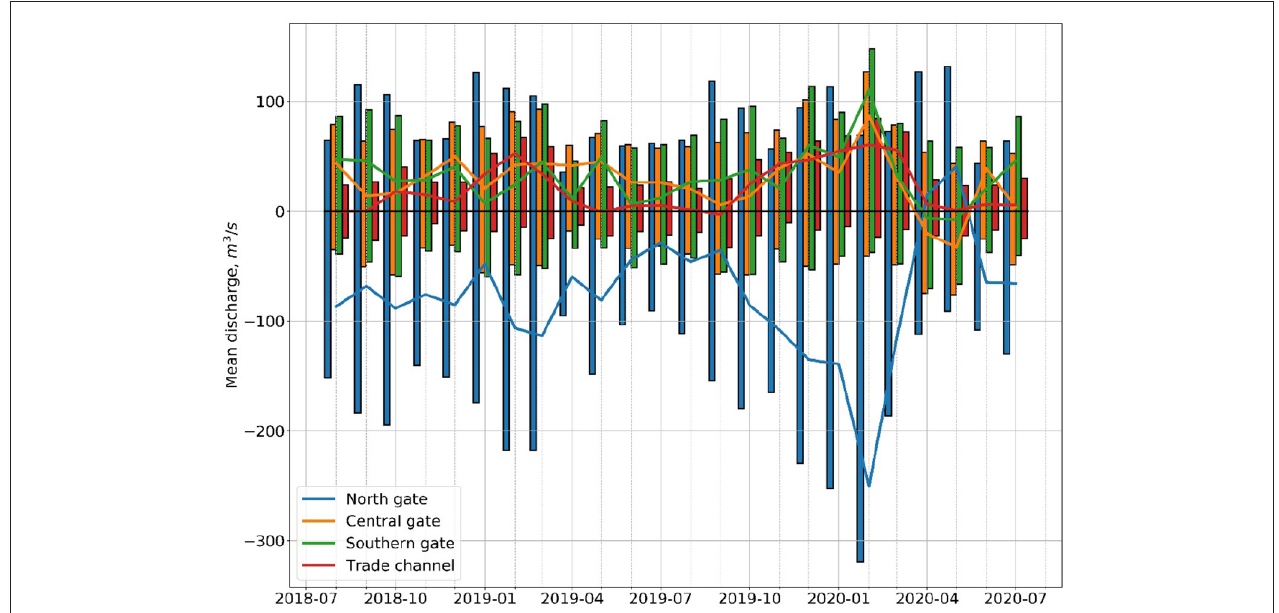
FIGURE 6 | Calculated monthly mean discharge through cross-sections on the boundaries of inner Liepaja port area. Positive discharge is into the inner port area, negative discharge is out of it. Mean positive, mean negative (bars), and mean total (lines) discharge for each of the cross-sections are shown.